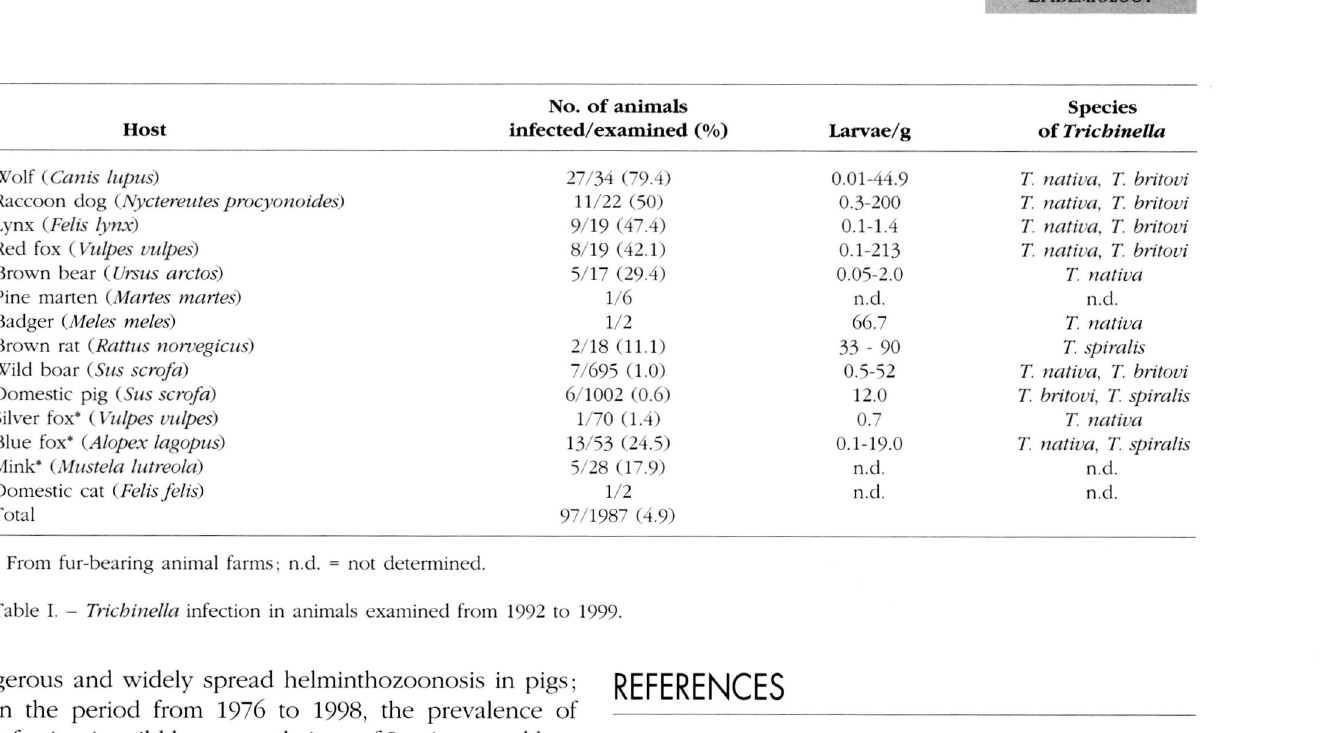
Table I. - Trichinella infection in animals examined from 1992 to 1999.